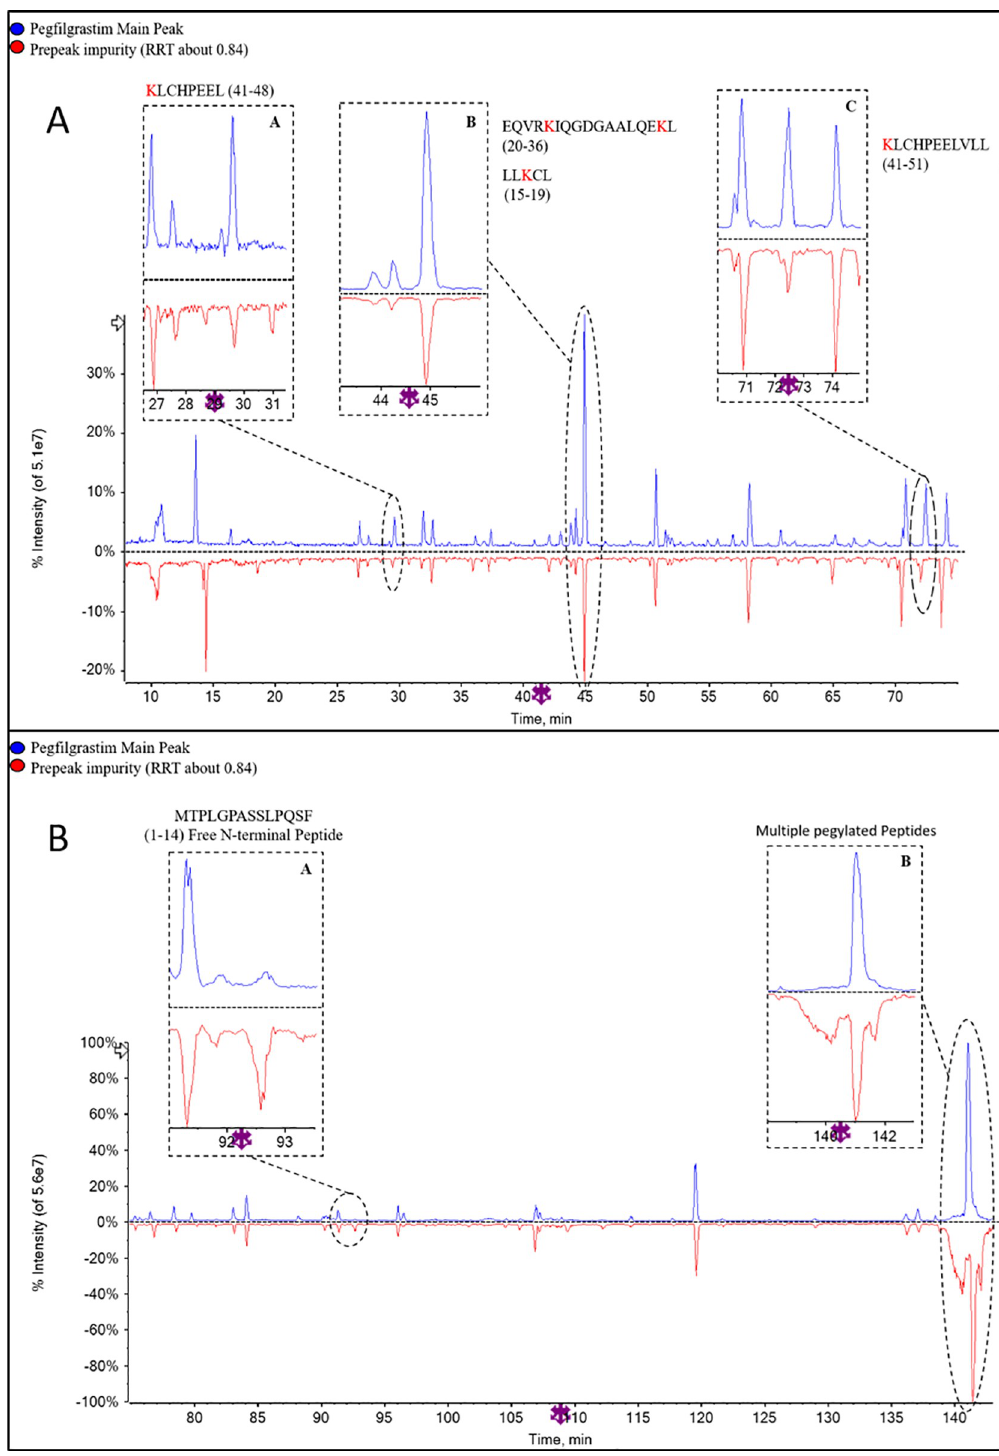
Fig 7. (A) TIC overlay of pegfilgrastim main peak and Pre-peak impurity (RRT 0.84) in peptide mapping (10–75 min) (B) TIC overlay of pegfilgrastim main peak and Pre-peak impurity (RRT 0.84) in peptide mapping (75–145 min).